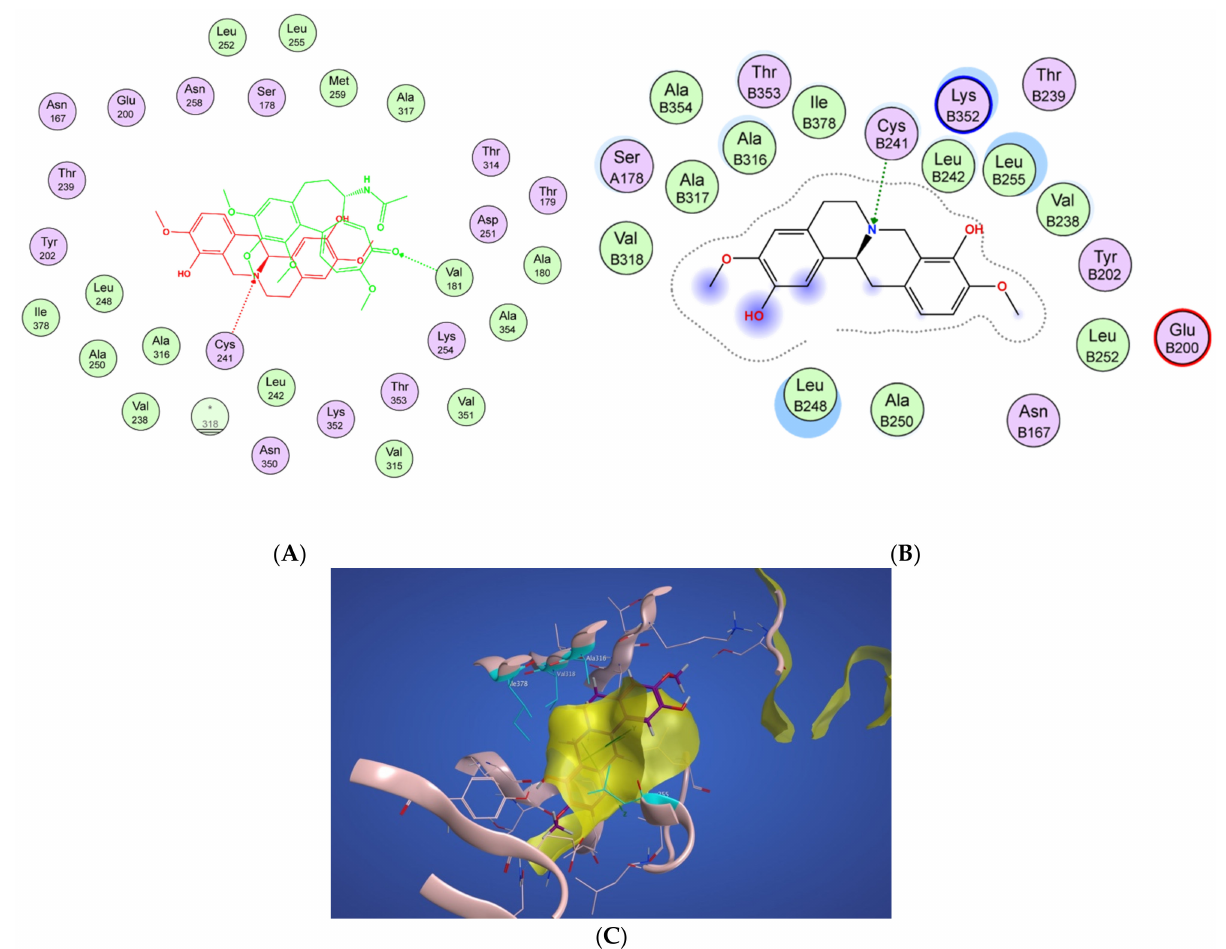
Figure 4. ( A ) Two-dimensional interaction scheme of the superimposed colchicine crystal structure from the 5NM5 PDB file (green) on scoulerine in the S 1 site (red) on 1SA0. Star (*) on residue 318 indicates two different amino acids on 5NM5 and 1SA0 structures. ( B ) Two-dimensional interaction scheme of scoulerine in the S 1 site. ( C ) Surface patches identifying regions of hydrophobicity (yellow) around scoulerine. Residues Leu255, Ala316, Val318, and Ile378 of β tubulin that are involved in hydrophobic interactions are colored in